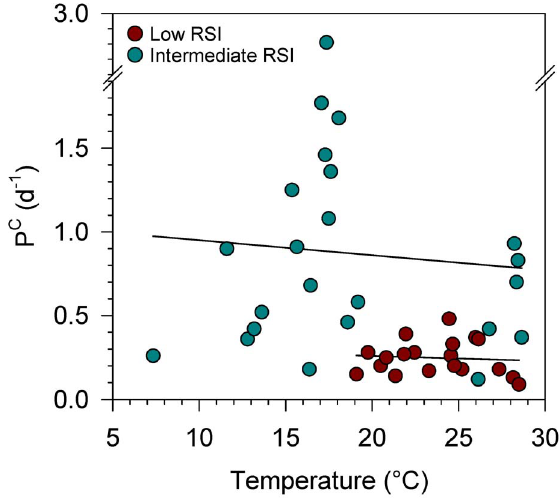
Figure 4. Temperature and phytoplankton growth in samples with different resource availability. Carbon-specific production rate (P C ) is plotted against temperature for oligotrophic stations with low resource supply index ( RSI , 10 mmolN kg 2 1 ) and temperate, upwelling and coastal stations with intermediate RSI (10–20 mmolN kg 2 1 ). Both linear regression fits were non-significant ( p . 0.6).